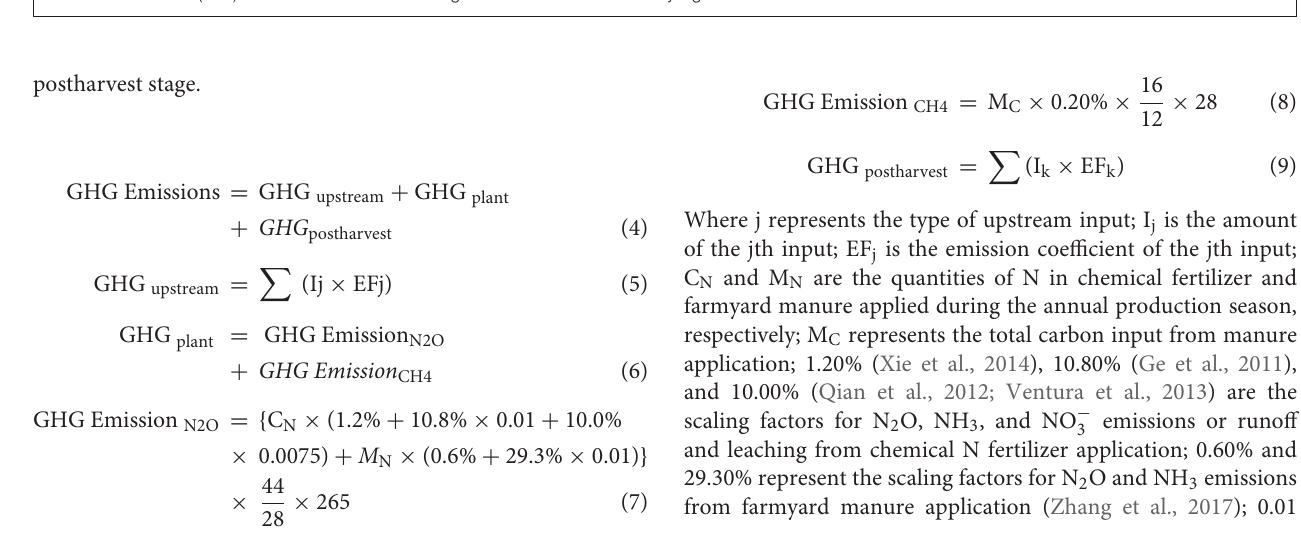
FIGURE 2 | Chemical fertilizer application time and amount in the different treatments of pomelo production. The black error bars in the figure indicate the overall standard deviations (SDs). Different letters above histogram bars indicate statistically significant differences at P < 0.05.